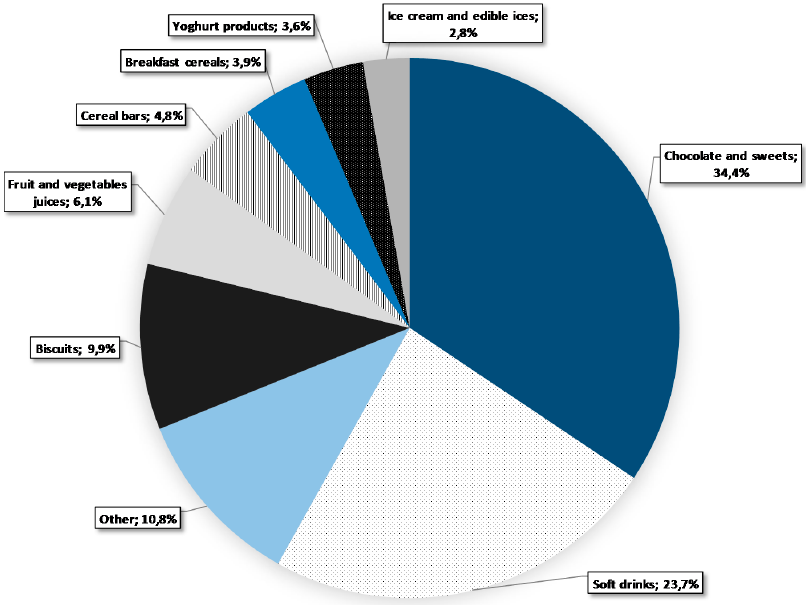
Figure 4. Relative contribution of different categories to the amount of free sugar sold.